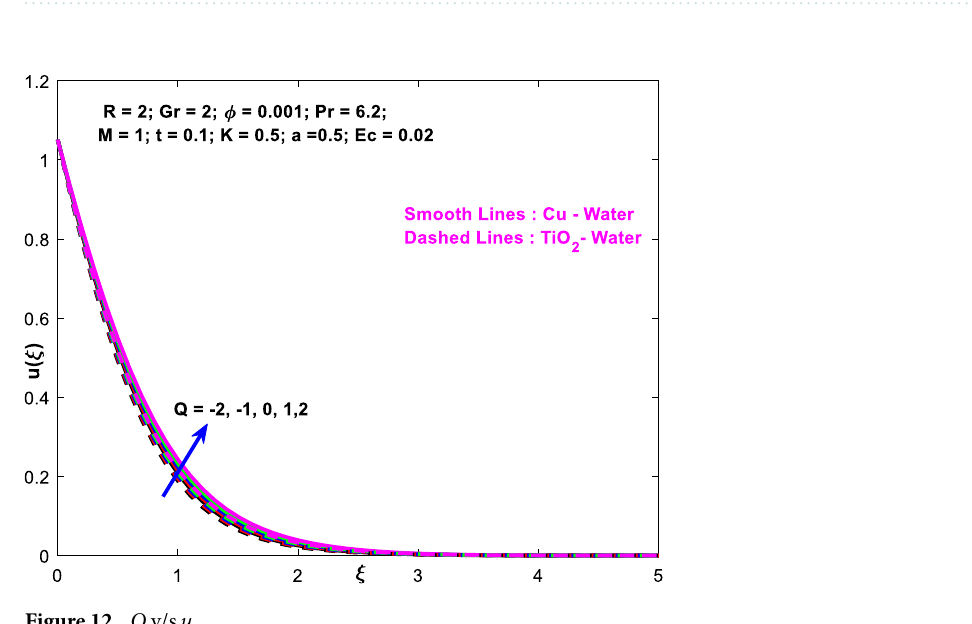
Figure 12. Q v/s u